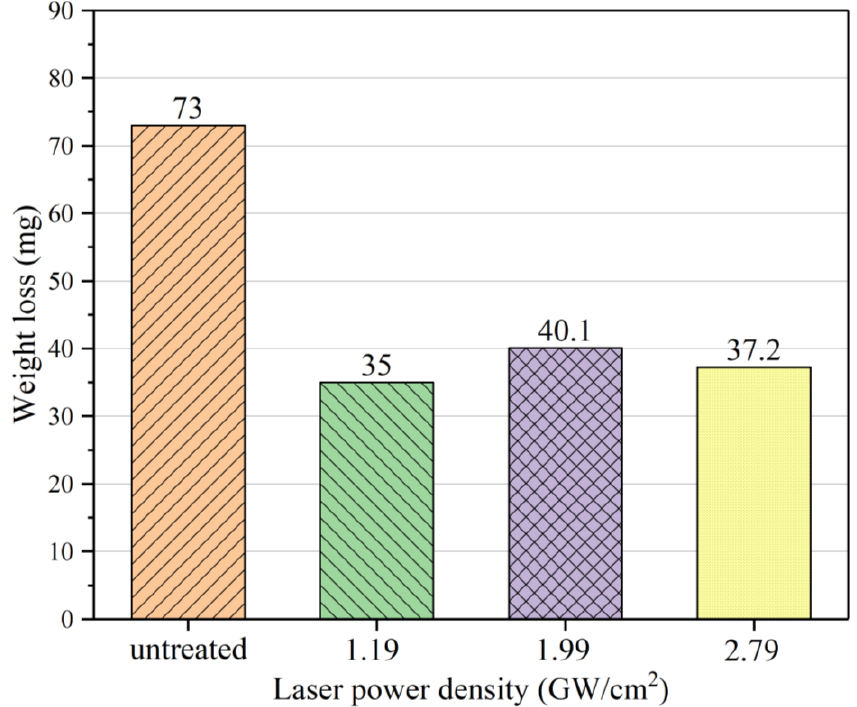
Figure 8. Total weight losses of four samples after 10 days.